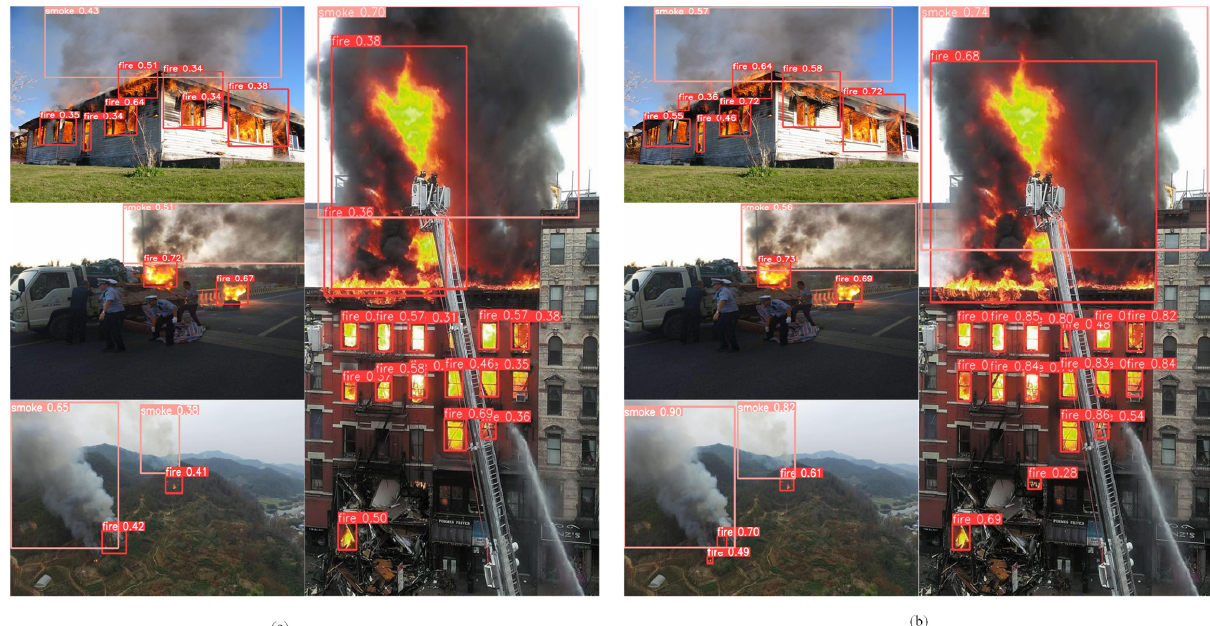
Figure 7. Comparison of Light-YOLOv5 and the original algorithm detection results. ( a ) YOLOv5n and ( b )